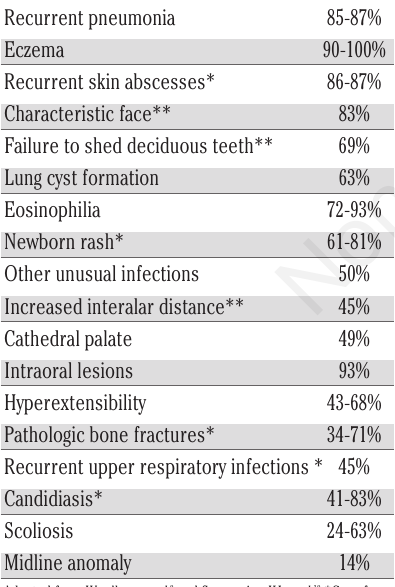
Table 2. Comparison of typical cohort of HIES patients and case.